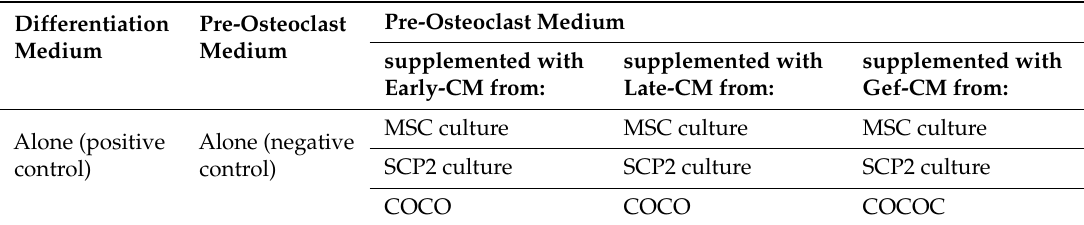
Table 1. Assay condition of the osteoclastogenesis